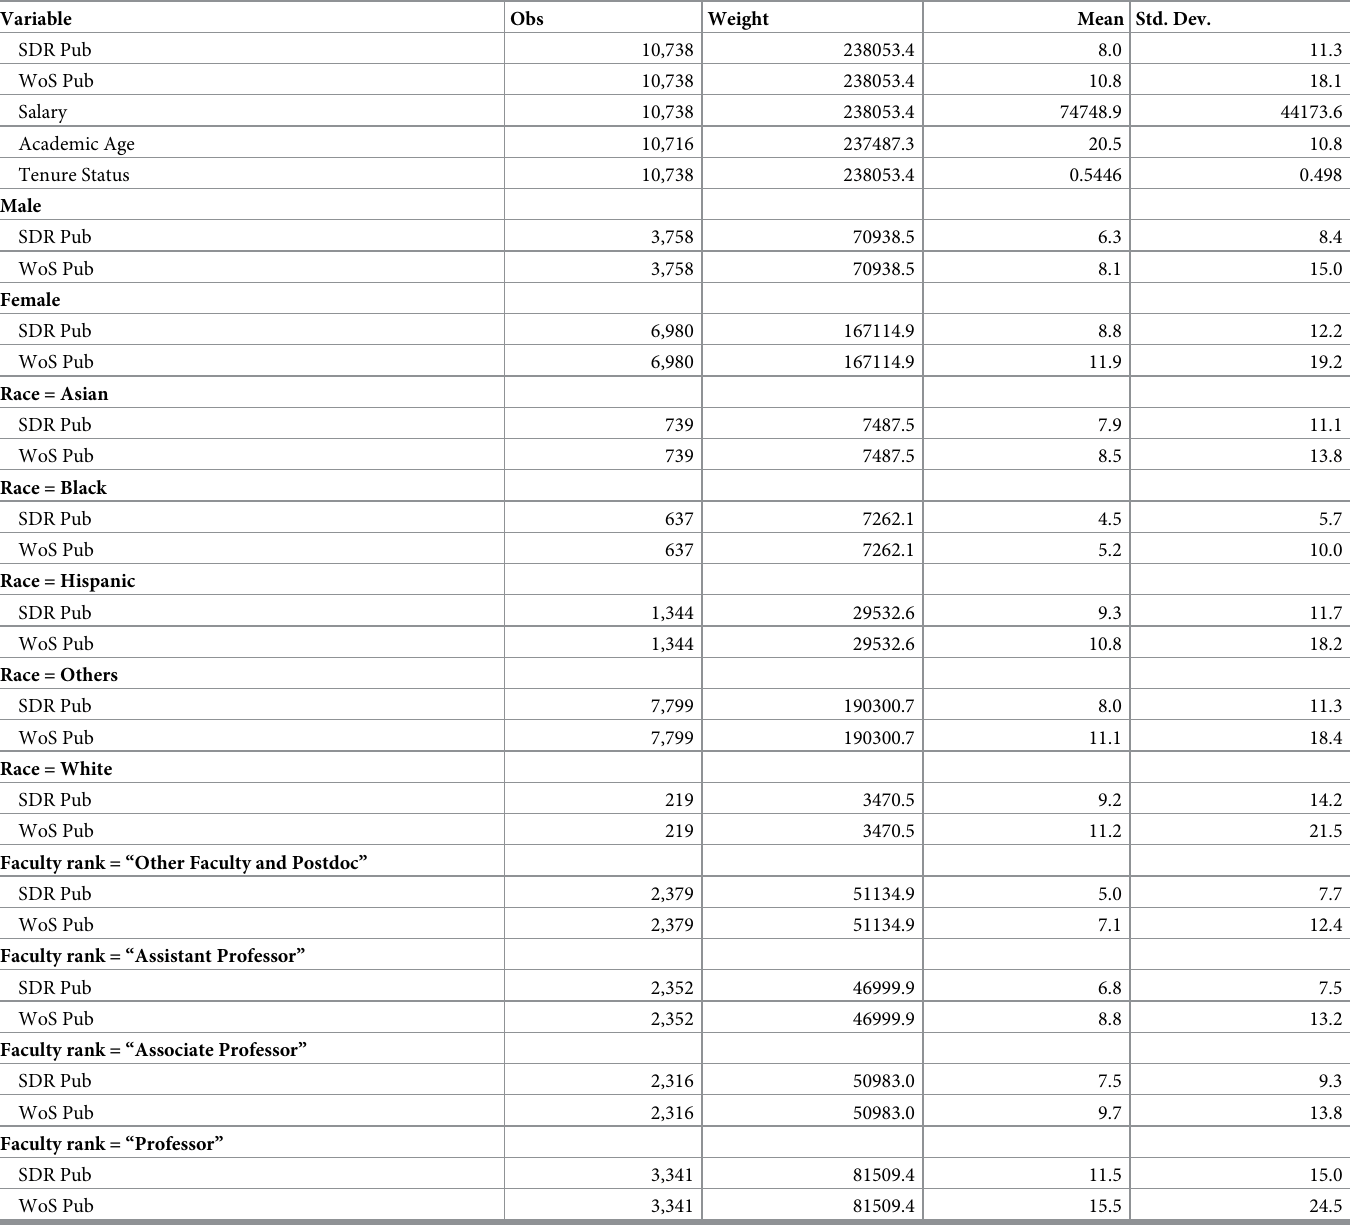
Table 1. Summary